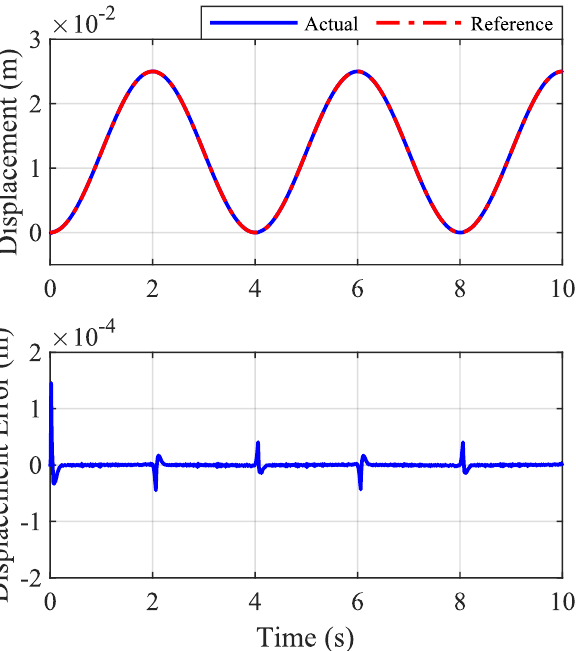
Figure 12. Experimental waveforms for sinusoidal position tracking at 0.25 Hz with α = 50, K v = 20, K p =